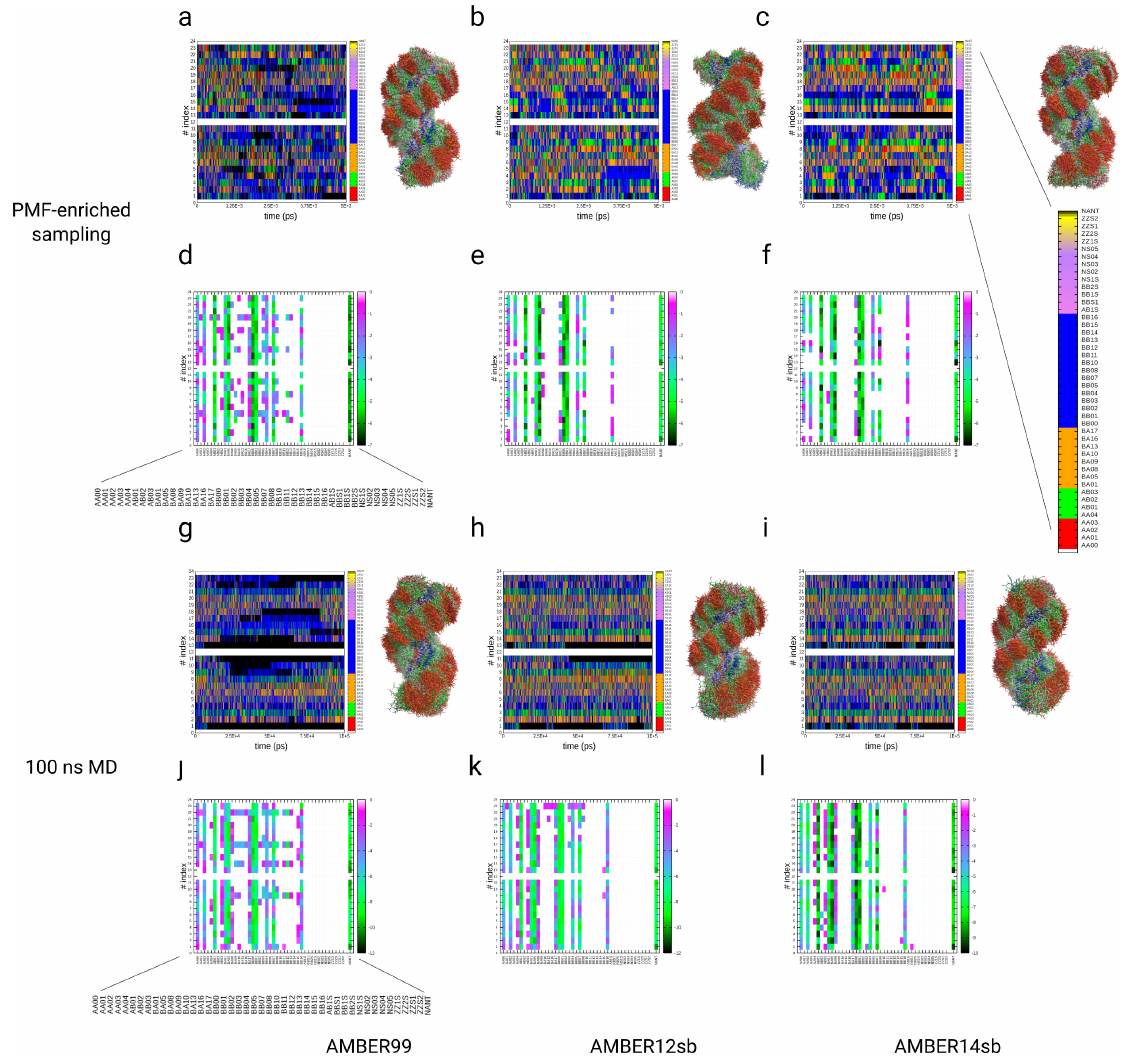
Figure 5. Results from the nucleotide conformer (NtC) assignment analysis of three PMF-enriched simulations of the Dickerson–Drew DNA dodecamer (with the coupling parameter α = 10 − 9 ) ( a – f ) (see Methods section). The overlaid structures of each trajectory are displayed on the right side of the panels ( a – c ) and ( g – i ). We compare the data with 100 ns MD simulations of the same systems with identical force field parameter sets ( g – l ). ( a – c , g – i ) NtCs as a function of time from the simulation using different conventional force fields ( H ( A ) ): AMBER99 ( a , d , g , j ), AMBER12sb ( b , e , h , k ), and AMBER14sb ( c , f , i , l ). ( d – f , j – l ) Free energy partition ( ∆ F = − k B T ln ( p / p min ) ) as a function of the conformer class index and the step-index along the DNA sequence from the simulations. The colored bar expresses the energies